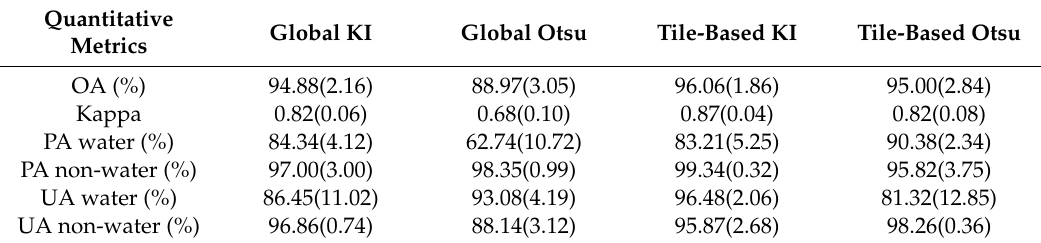
Figure 8. Histograms and the corresponding optimal local thresholds derived by di ff erent methods for the Sentinel-1 SAR VV polarization scenes. ( a – d ) represents the Sentinel-1 SAR images acquired on 23 May 2017, 22 July 2017, 20 September 2017, and 9 October 2018, respectively. Table 3. Mean (standard deviation) quantitative metric values of water extraction results for the whole study area with the initial water map derived by di ff erent thresholding